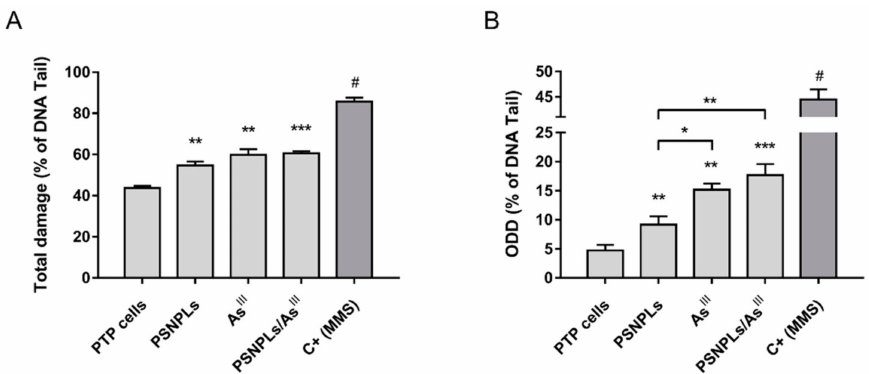
Figure 4. DNA damage induced by the long-term (co)exposure to As III and PSNPLs measured by the comet assay. ( A ) Total and ( B ) oxidative DNA damage levels after a 12-week exposure of PTP cells to 25 µ g/mL PSNPLs, 2 µ M As III, and the combination of both PSNPLs/As III treatments. Methyl methanesulfonate (MMS; 200 µ M) was used as a positive control. Data are presented as mean ± SEM analyzed by one-way ANOVA with Dunnett’s post-test (*** p < 0.001, ** p < 0.01, * p < 0.05 compared to passage-matched PTP cells or other conditions as indicated; # p < 0.001 when compared to all tested conditions).